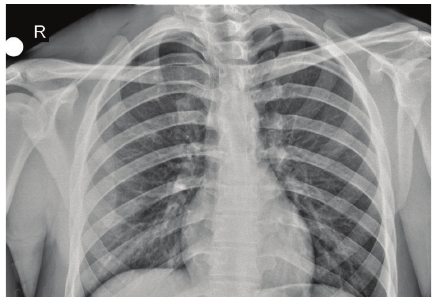
Figure 1: Preop radiographs.